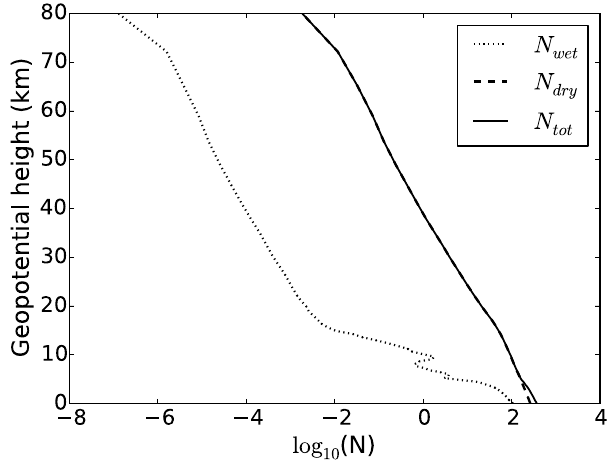
Figure 1. Logarithm (base 10) of a randomly selected (but fairly typical) vertical refractivity profile, forward modelled from a 70- level Met Office background profile. This highlights the approxi- mately exponential behaviour of refractivity with height. The dry and wet terms have also been plotted to show their relative contri-